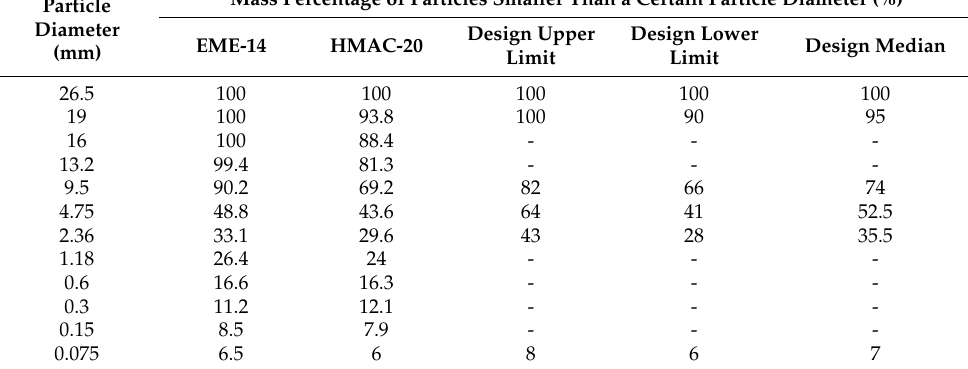
Table 4. Synthetic gradation design of high-modulus mixture.